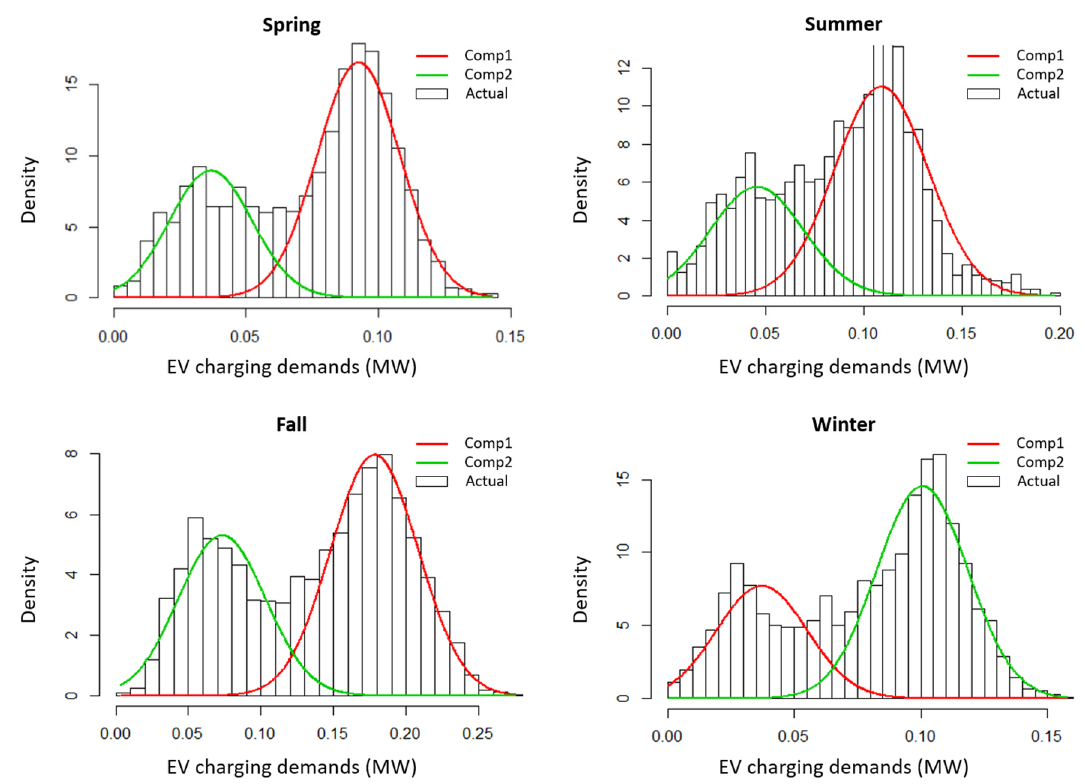
Figure 3. Seasonal Gaussian mixture distributions of the EV charging demand.